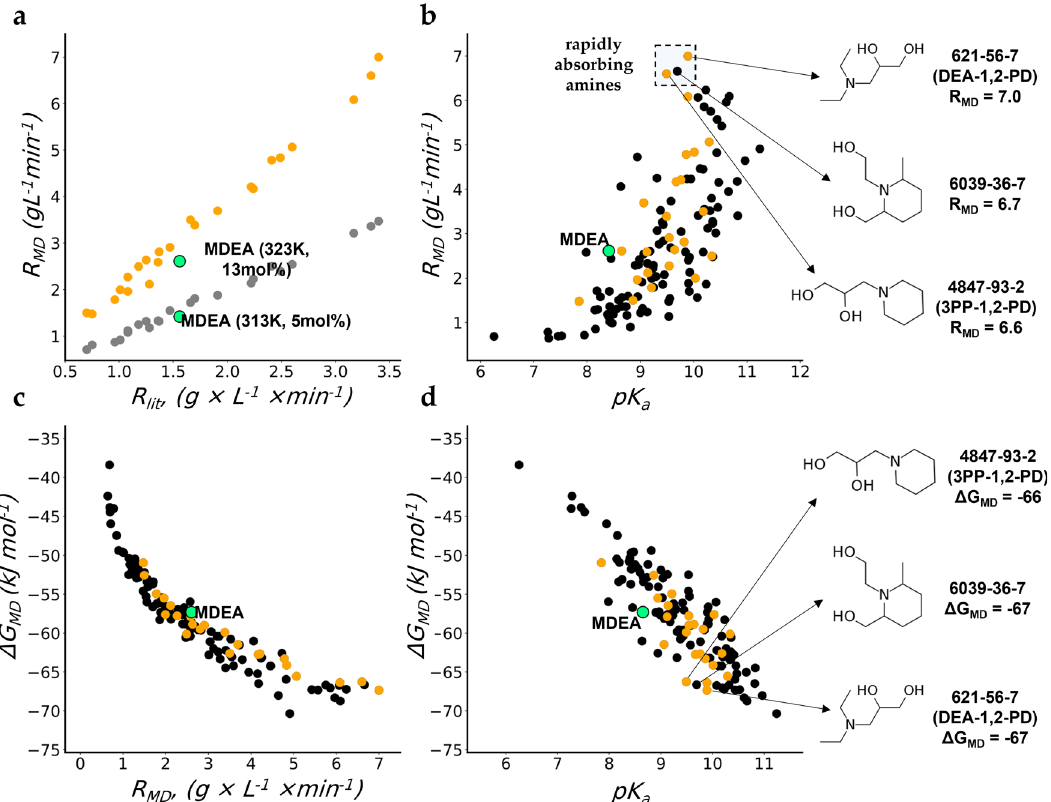
Fig. 2 Results of molecular dynamics simulations of the CO 2 absorption process. a CO 2 absorption rates (R MD ) at 313 K (gray) and 323 K (orange) predicted using MD and the experimental absorption rates (R lit ) at 313 K. b R MD vs predicted pK a values (pK a ). c energy of absorption ( Δ G MD ) predicted by MD vs R MD . d Δ G MD vs predicted pK a . The 24 amines from Chowdhury et al. 20 are shown in orange. The 100 amines for which MD simulations were performed are shown in black. Industrially used reference compound (MDEA) is shown in green.